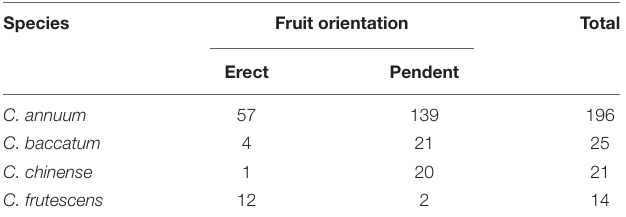
TABLE 1 | Segregation of fruit orientation in different pepper species in the core collection used for GWAS. Species Fruit